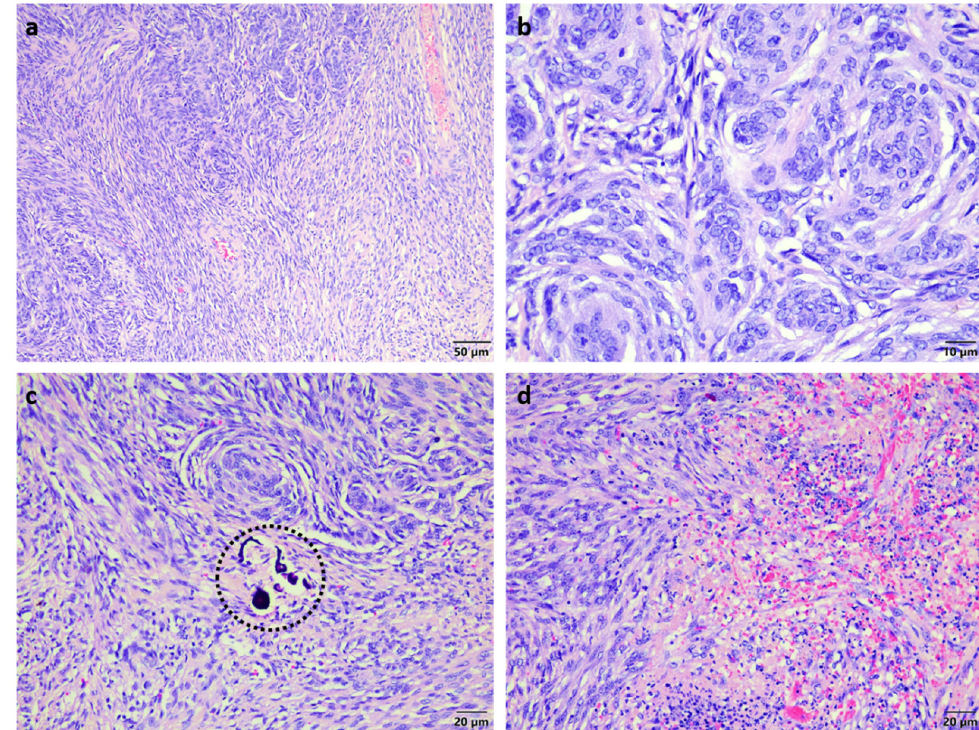
Figure 2. Histopathology of the sinonasal meningioma. ( a ) Low magnification revealing the transi- tional pattern made up of streams and whorls of neoplastic cells. ( b ) High magnification revealing the cellular morphology. ( c ) Presence of rare psammoma bodies (dashed circle). ( d ) Areas of necrosis with haemorrhage and neutrophil